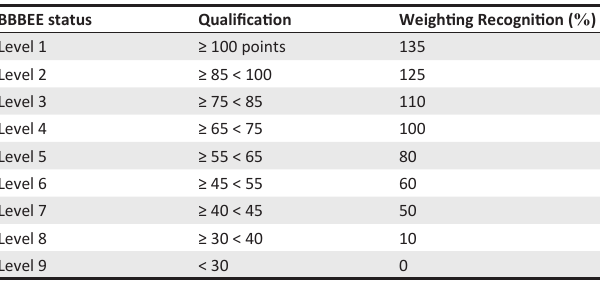
TABLE 1: Procurement